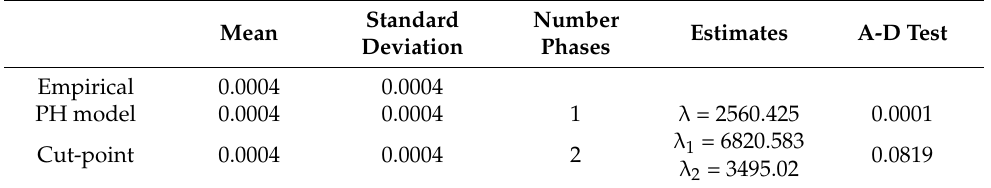
Table 4. Summary for the PH and one cut-point adjustment for the set